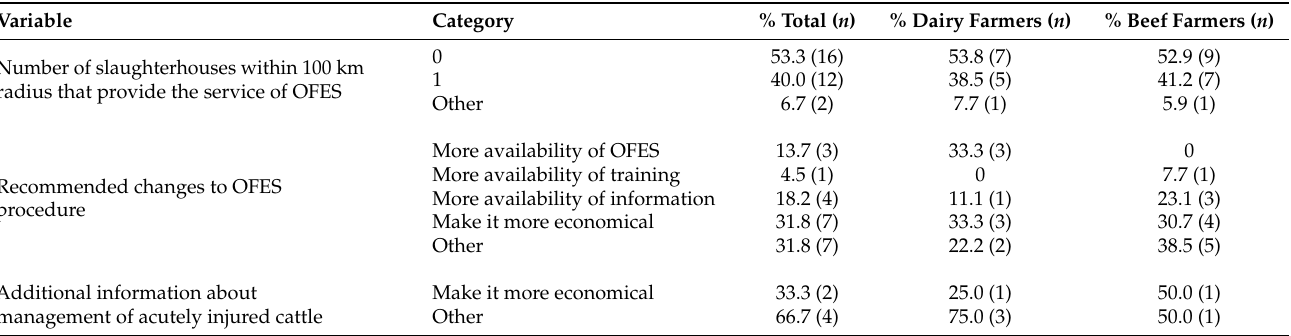
Table 5. Availability of On-Farm Emergency Slaughter (OFES) and Farmer Recommendations for Improvements to the OFES Procedure